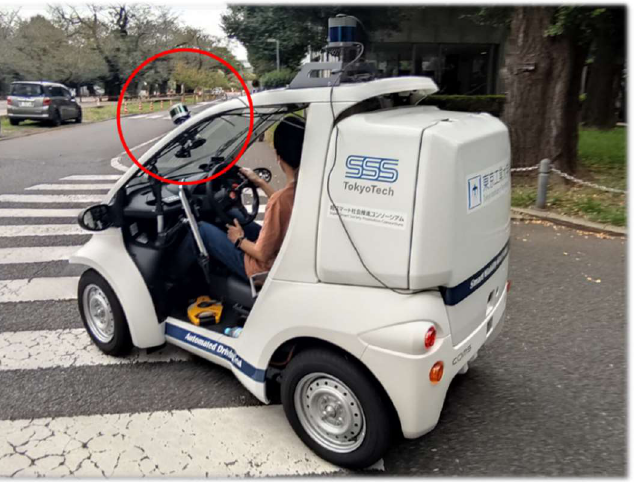
Figure 2. The small vehicle used for LiDAR scanning, with the LiDAR sensor encircled in